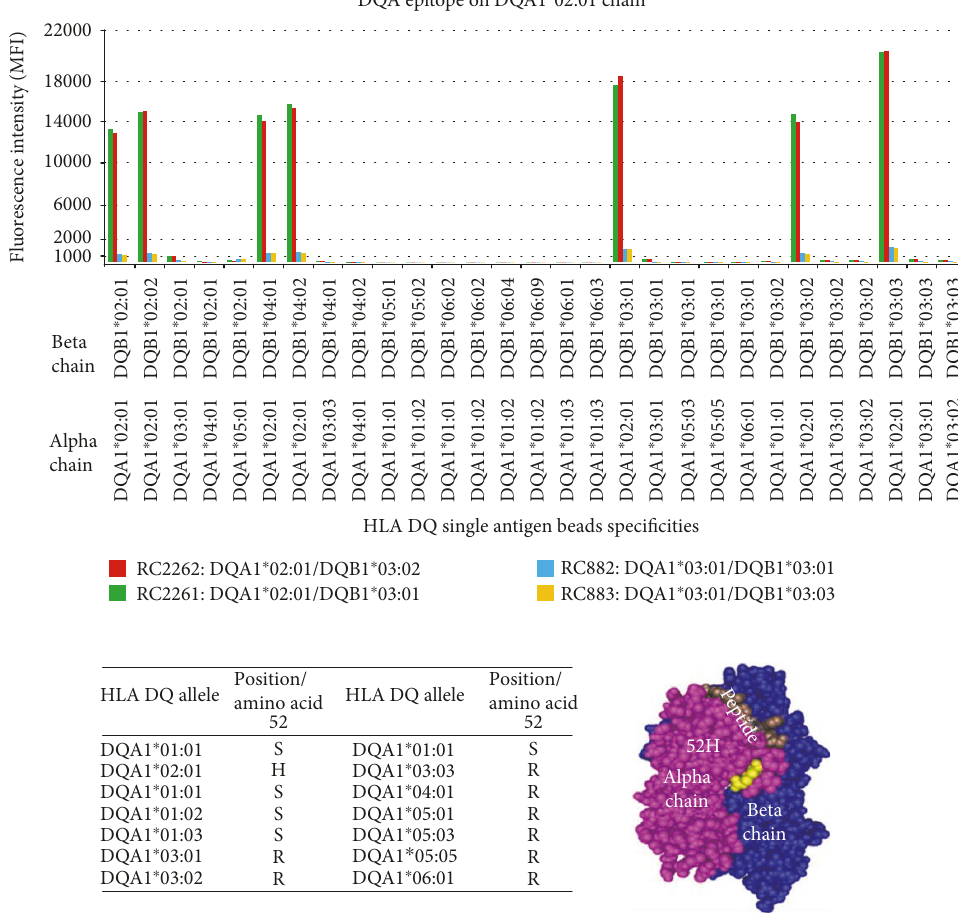
Figure 13: Several DQ antigens (heterodimers) with the DQA1 ∗ 02 01 chain are shown below. They all share epitope 2017 which is de fi ned by histidine (H) in position 52 of DQA1 ∗ 02 01 chain. Eluted antibodies from relevant DQ antigens are positive (red and green bars). Eluted antibodies from irrelevant (no DQA1 ∗ 02 01 ) are negative (yellow and blue bars).